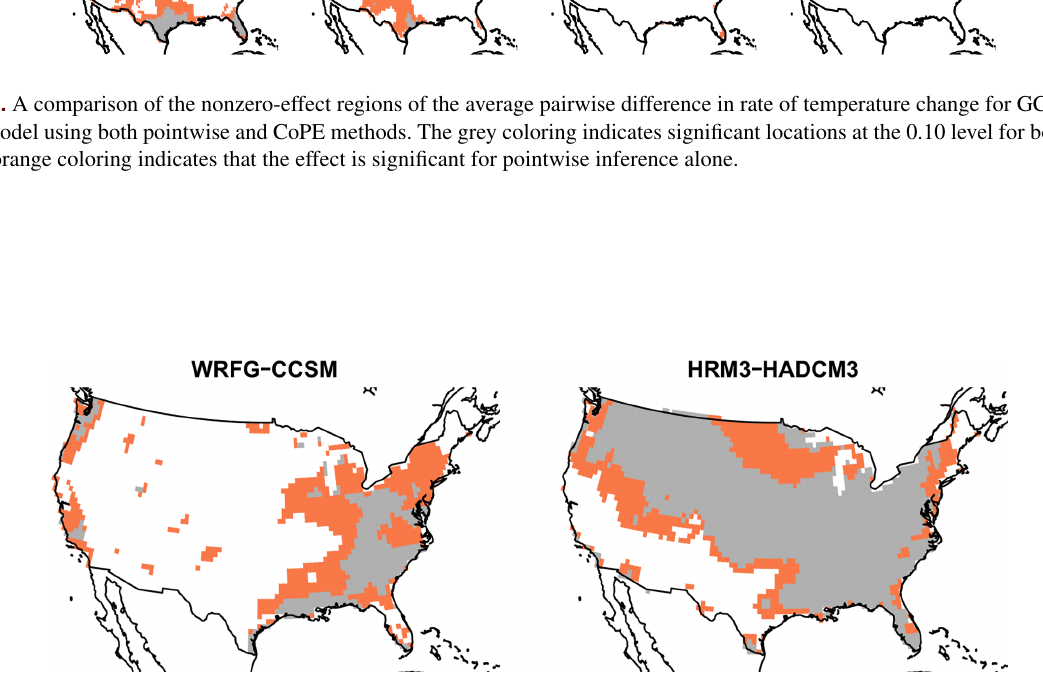
Figure A5. A comparison of the nonzero-effect regions of the average interaction effect of the IPL model using both pointwise and CoPE methods. The grey coloring indicates significant locations at the 0.10 level for both methods, while the orange coloring indicates that the effect is significant for pointwise inference